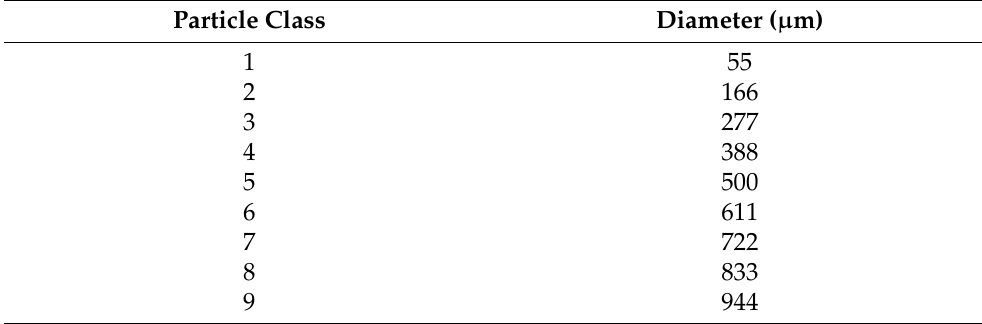
Table 1. Particles with different diameters in the polydisperse spray